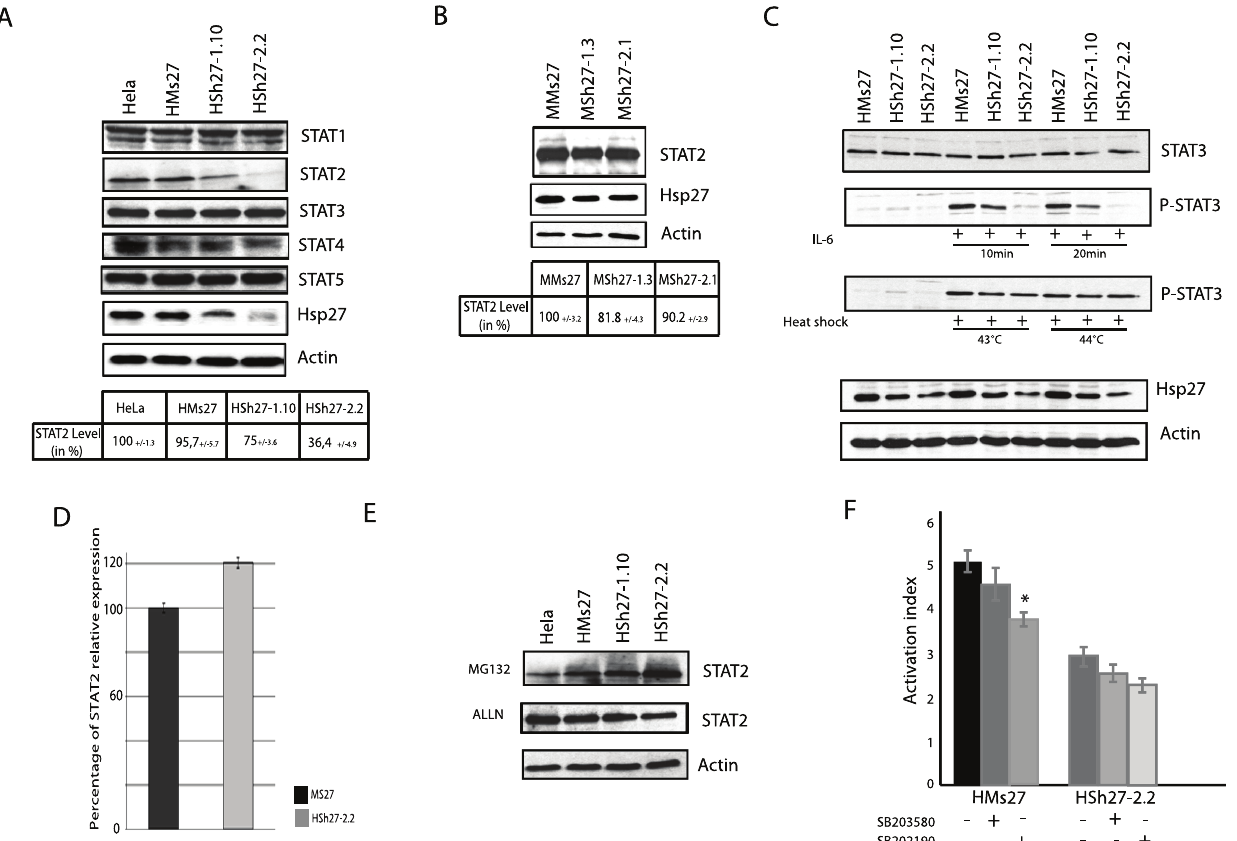
Figure 5. Endogenous level of STAT2 is decreased in Hsp27 depleted cell line. A , Hsp27 depleted and control HeLa cells were collected, and samples were analyzed by immunoblotting using antibodies that recognize the different STAT polypeptides. Quantification of STA2 level was reported in a table. B , as in A ) but analysis of STAT2 level in MCF-7 depleted cells. C, Analysis of STAT3 phosphorylation. HeLa clones were treated with interleukin-6 (4 h; 125 ng/mL) or heat shock (60 min; 42 u C and 44 u C). Samples were collected and analyzed by immunobloting with STAT3, Phospho- STAT3, Hsp27 and actin antibodies. D , quantification of stat2 gene relative expression by qPCR. E , Effect of proteolytic inhibitors. HeLa cells were analyzed after being treated with MG132 or ALLN, as described in Fig. 3. Level of STAT2 was revealed by immunobloting. F , HeLa cells were transiently transfected with an ISRE reporter gene construct [36] and treated for 6 h with 50 U/mL of interferon- a . They were also treated or not for 30 min with 10 m M of either SB203580 or SB202190 (p38MAPkinase and MK2 inhibitors, respectively) before exposure to interferon- a . Luciferase expression correlated with STAT2 transcriptional activity was quantified in both cell lines.